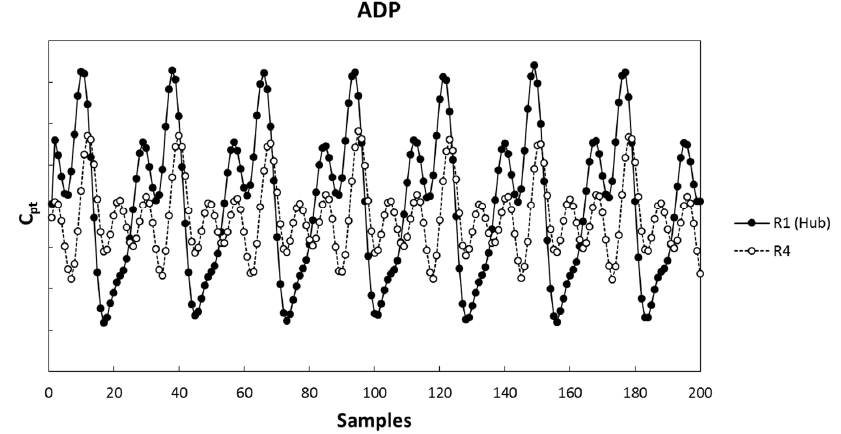
Figure 3. Development of total pressure coefficient for two radial measurement positions after phase averaging (just periodic component) obtained from Fast Response Aerodynamic Pressure Probe (FRAPP) measurement. MP: Measurement point.